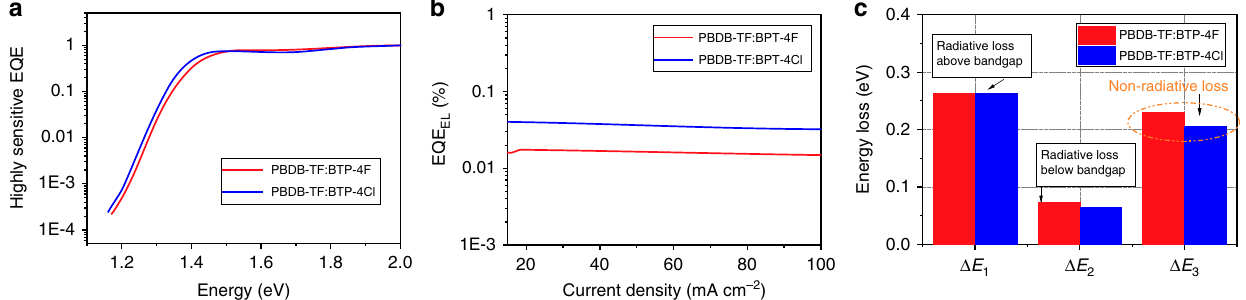
Fig. 4 Energy loss. a Highly sensitive EQE curves of both devices. b EL quantum ef fi ciencies of the solar cells at various injected current densities. c Radiative and non-radiative energy losses in the OPV